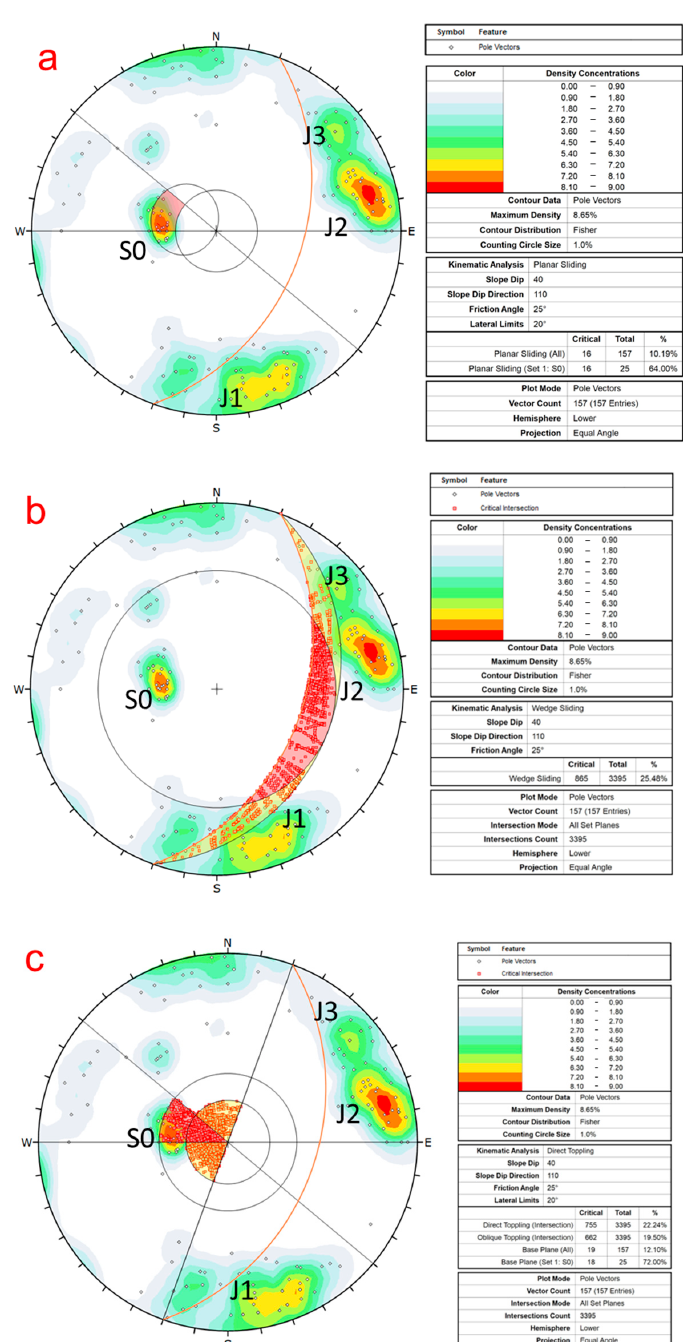
Figure 12. Kinematic analysis of the translational landslide, ( a ) planar sliding, ( b ) wedge sliding, and ( c ) direct toppling.